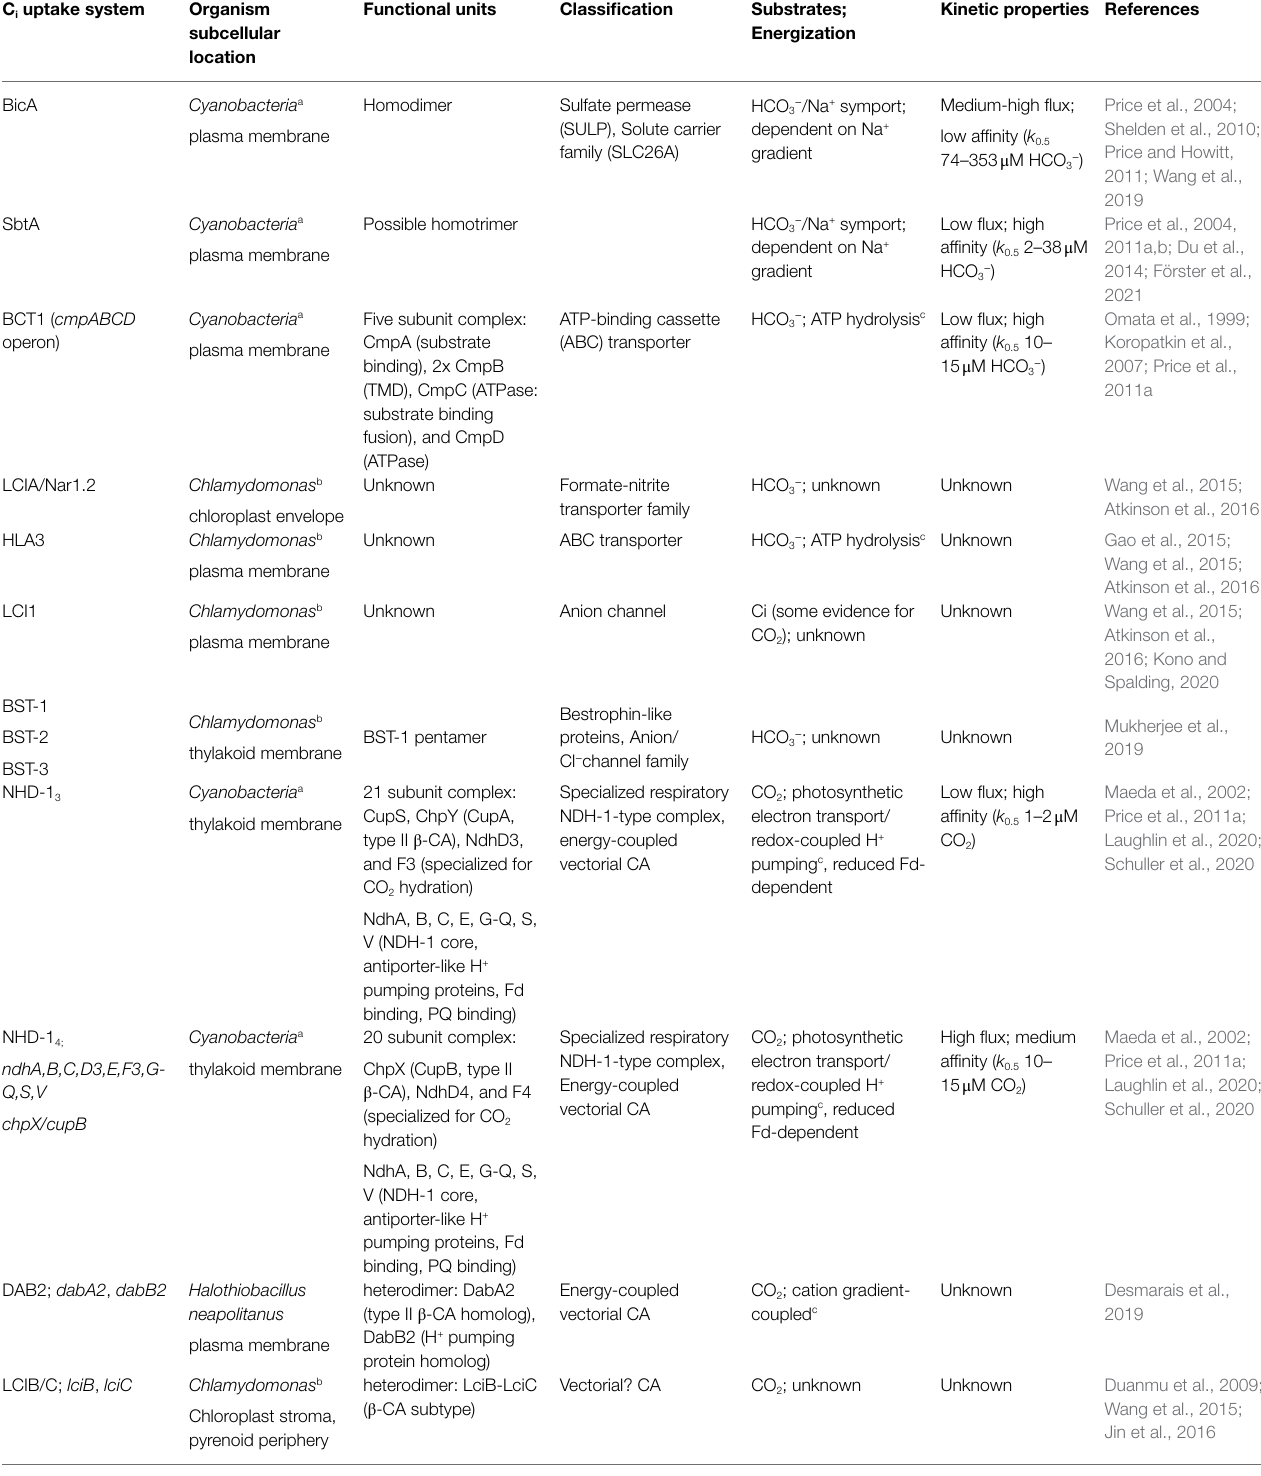
TABLE 1 | Inorganic carbon (C i ) uptake systems relevant to expression of CCMs in